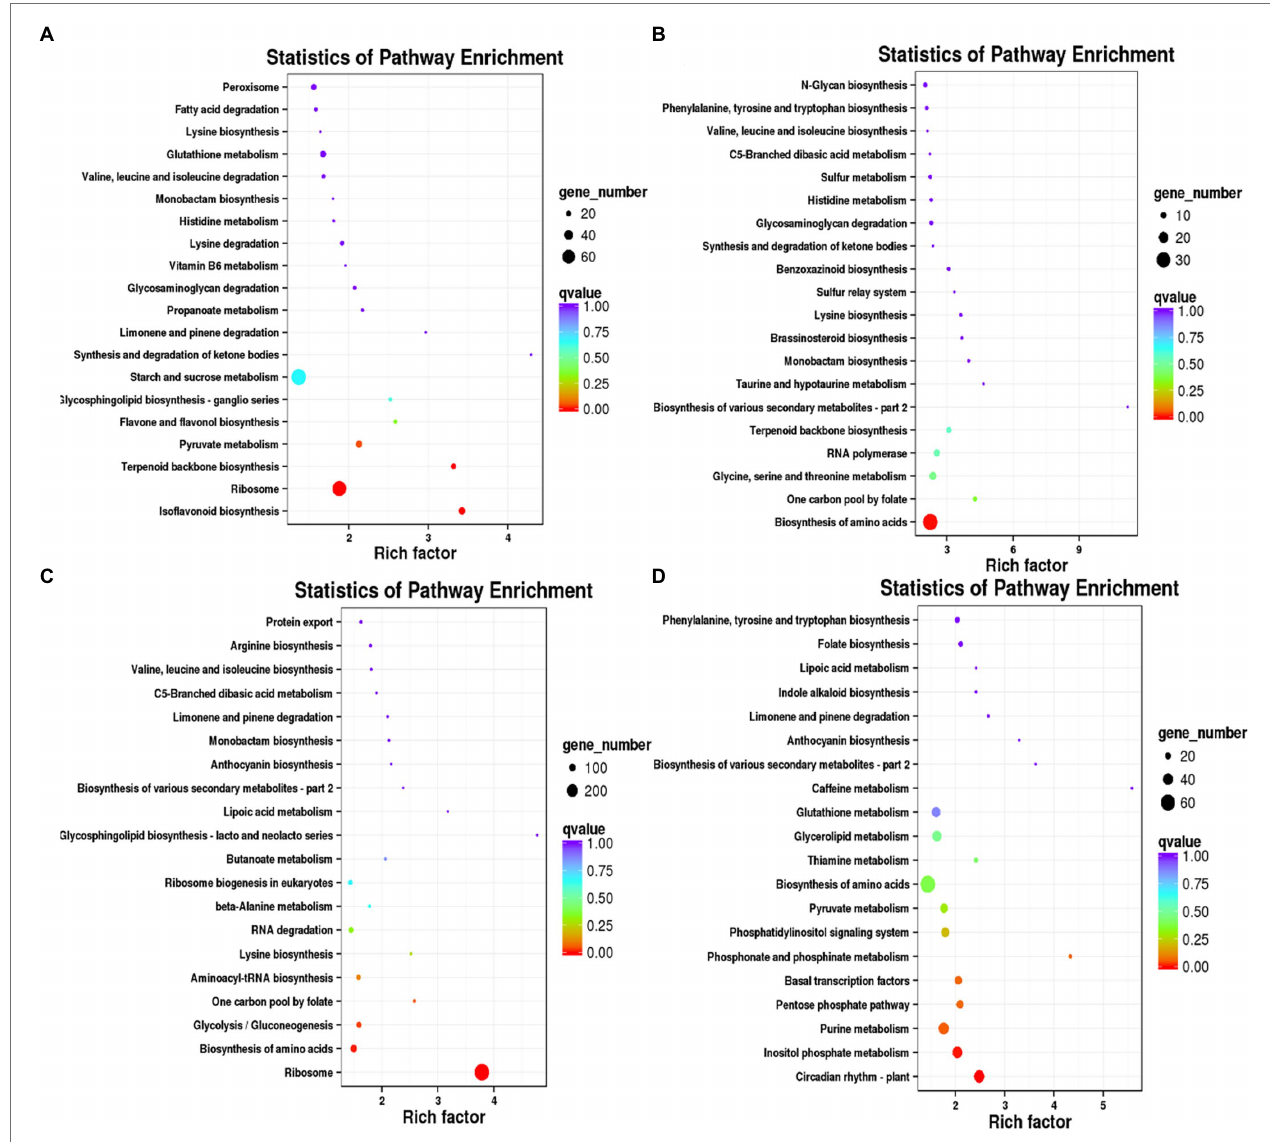
FIGURE 5 | KEGG enrichment analysis of DEGs specific to days 7, 14, 21, and 28 in Dryland inoculated with Verticillium alfalfae (HD + V). (A) KEGG enrichment analysis of DEGs specific to days 7. (B) KEGG enrichment analysis of DEGs specific to days 14. (C) KEGG enrichment analysis of DEGs specific to days 21. (D) KEGG enrichment analysis of DEGs specific to days